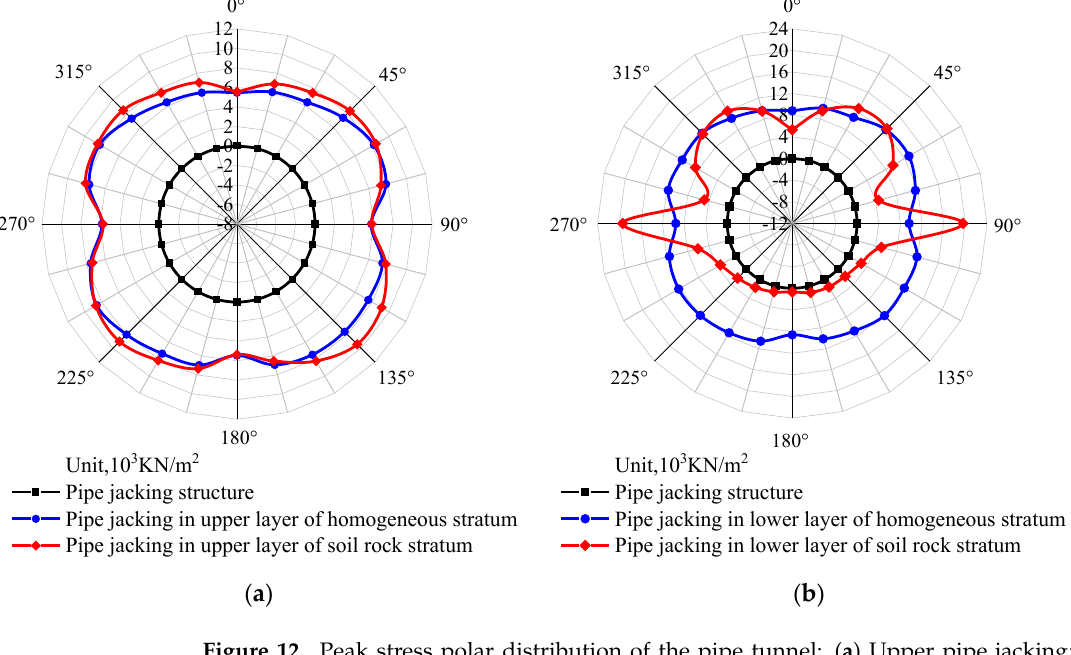
Figure 12. Peak stress polar distribution of the pipe tunnel: ( a ) Upper pipe jacking; ( b ) Lower pipe jacking.